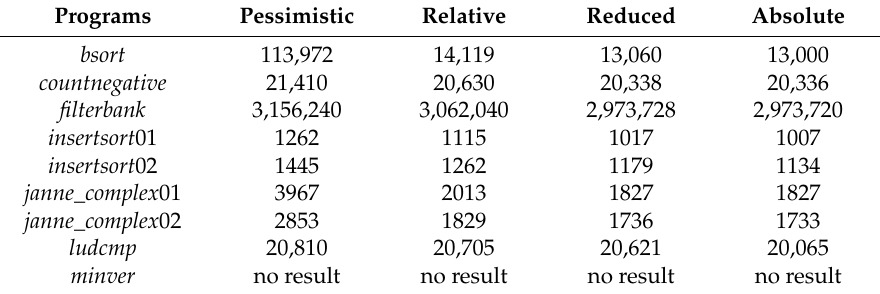
Table 4. WCET obtained from different constraints on complex processor (unit: cycle).